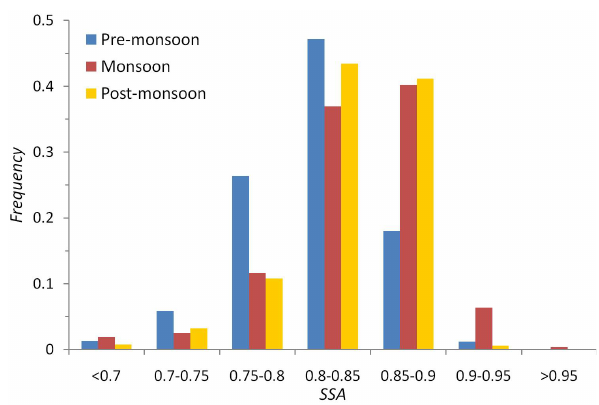
Fig. 9. Histogram of SSA values in Mukteshwar during pre- monsoon, monsoon and